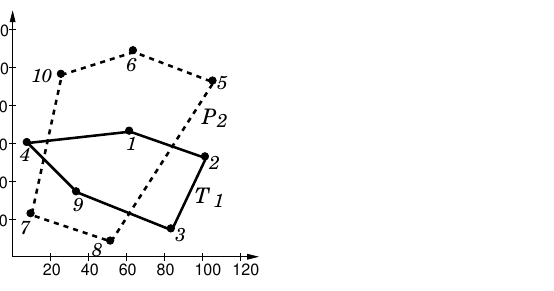
Figure 18. Tour T 1 and polygon P 2 for the example instance “tsp10”.